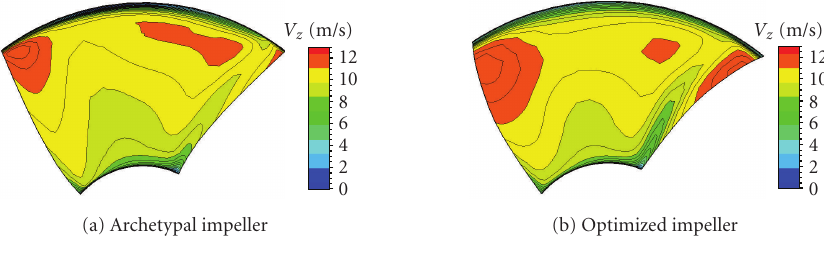
Figure 16: Distribution of axial